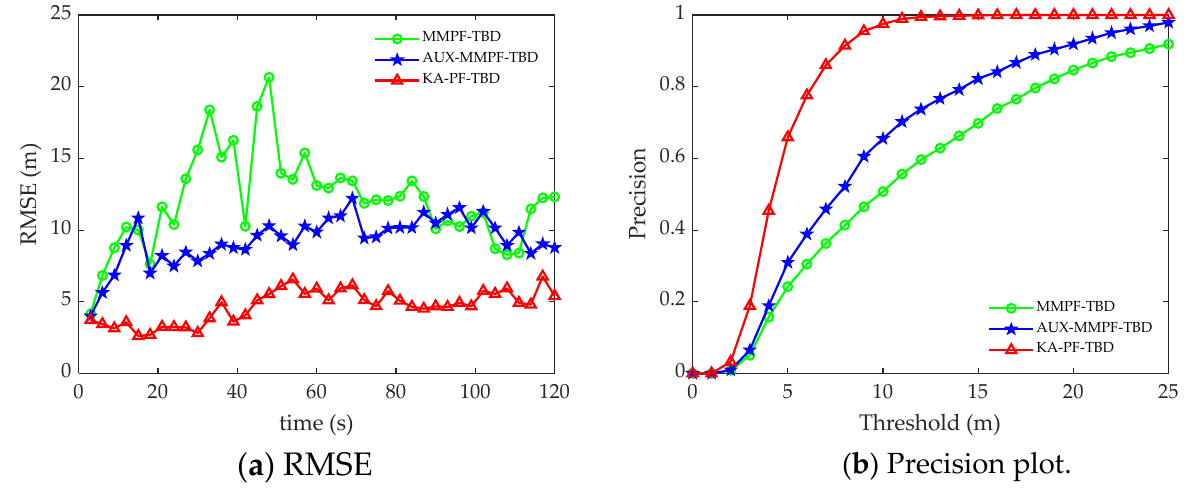
Figure 12. The trial data processing results. ( a ) The RMSE plotted against time. ( b ) Precision plotted against time.